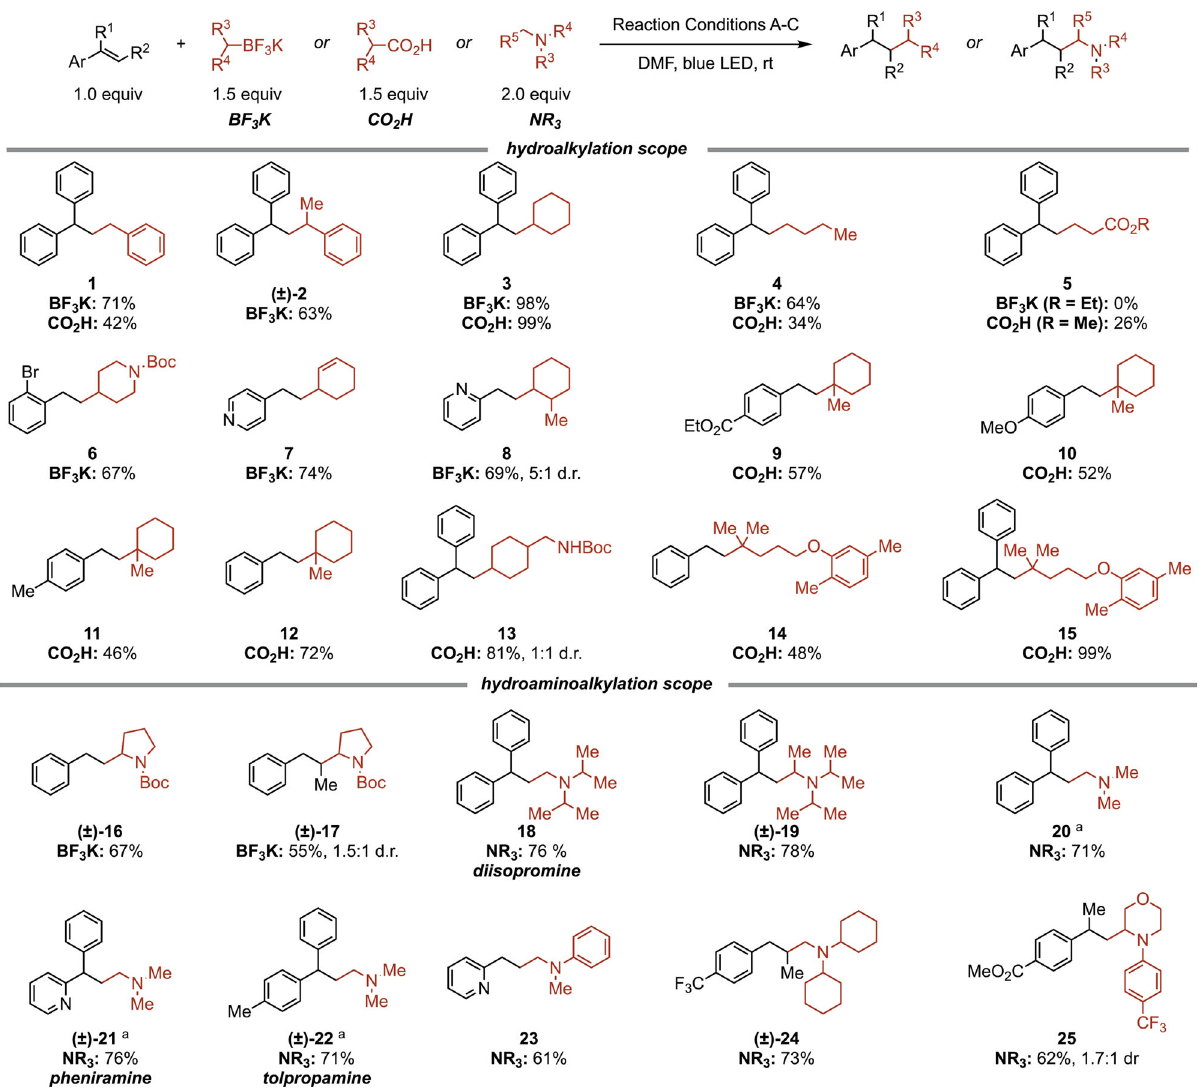
Fig. 3 Scope of hydro(amino)alkylation. Conditions A: tri fl uoroborate salt (1.5 equiv), PC (1.0 mol%), 2-methoxylphenol (3.0 equiv), DMF (0.1 M), r.t., 48 h; Conditions B: carboxylic acid (1.5 equiv), PC (1.0 mol%), K 3 PO4 (1.5 equiv), DMF (0.2 M), r.t., 24 h; Conditions C: tertiary amine (2.0 equiv), PC (0.5 mol%), DMF (0.2 M), r.t., 24 h. a Me 3 N ⋅ HCl (3.0 equiv) and DBU (3.0 equiv) were used. See Supplementary Methods for experimental details.